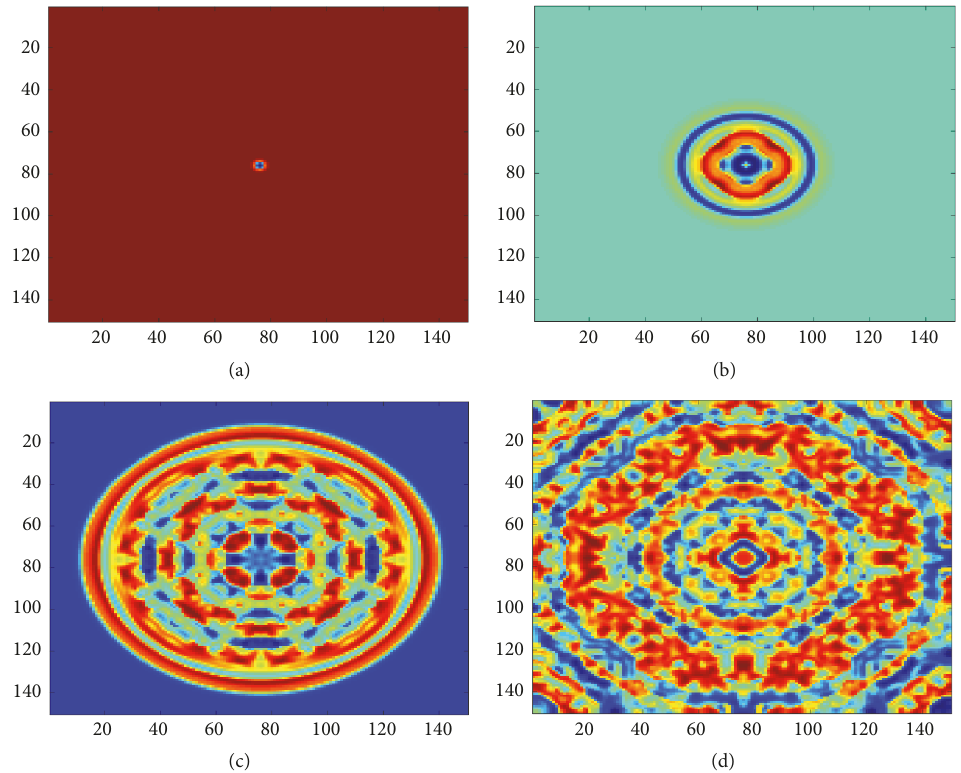
Figure 7: The snapshots of spatial distribution of membrane potential with color scale for neurons in the square array network for 𝑘 = 0.8 and 𝐷 = 1 at (a) 𝑡 = 2 time units, (b) 𝑡 = 75 time units, (c) 𝑡 = 170 time units, and (d) 𝑡 = 300 time